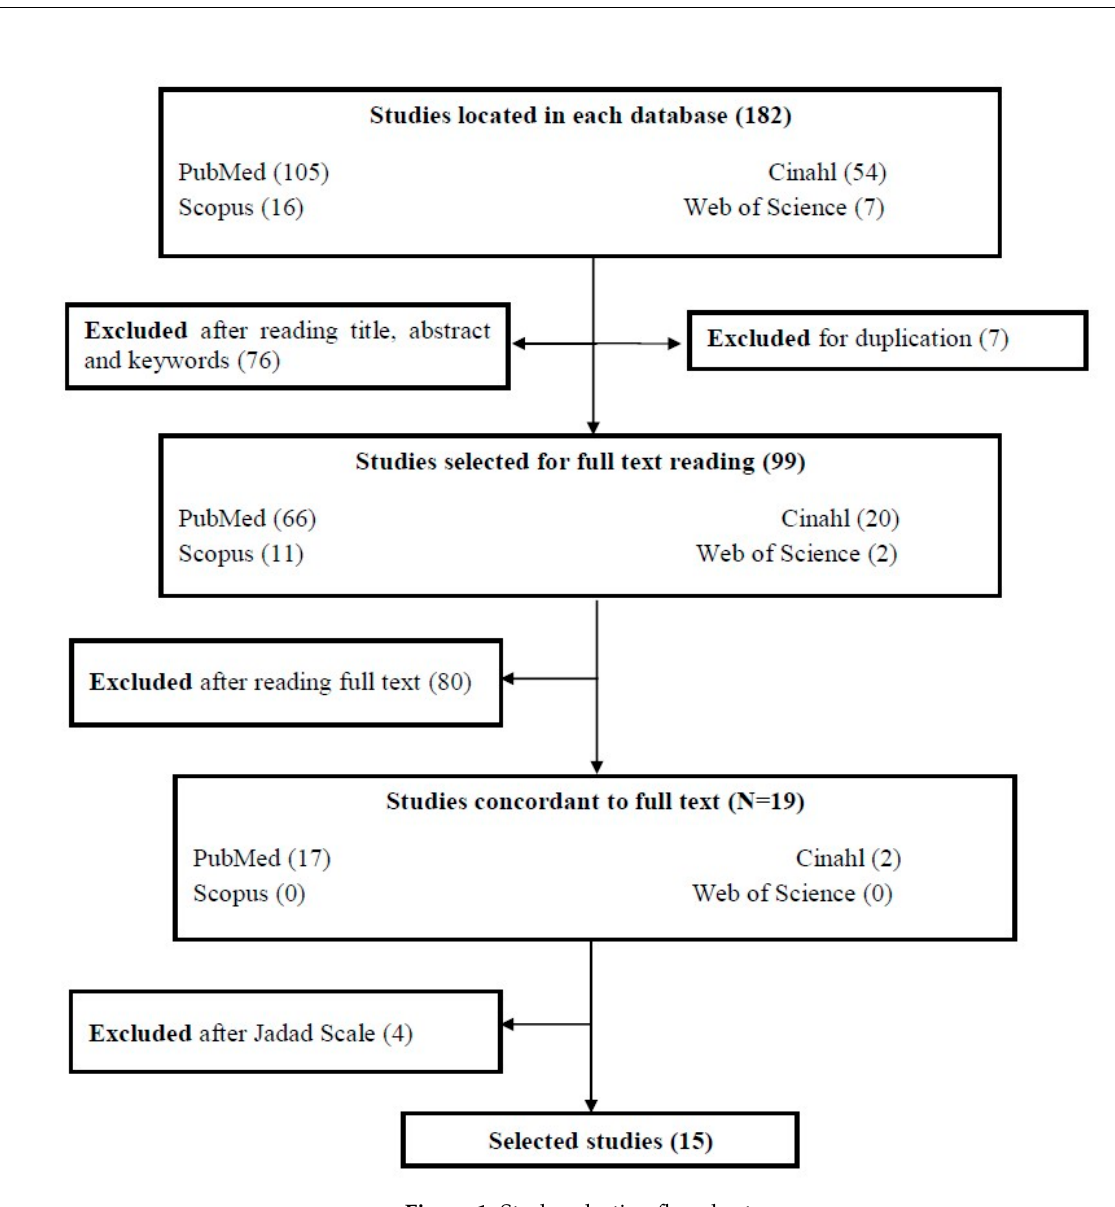
Figure 1. Study selection flowchart.